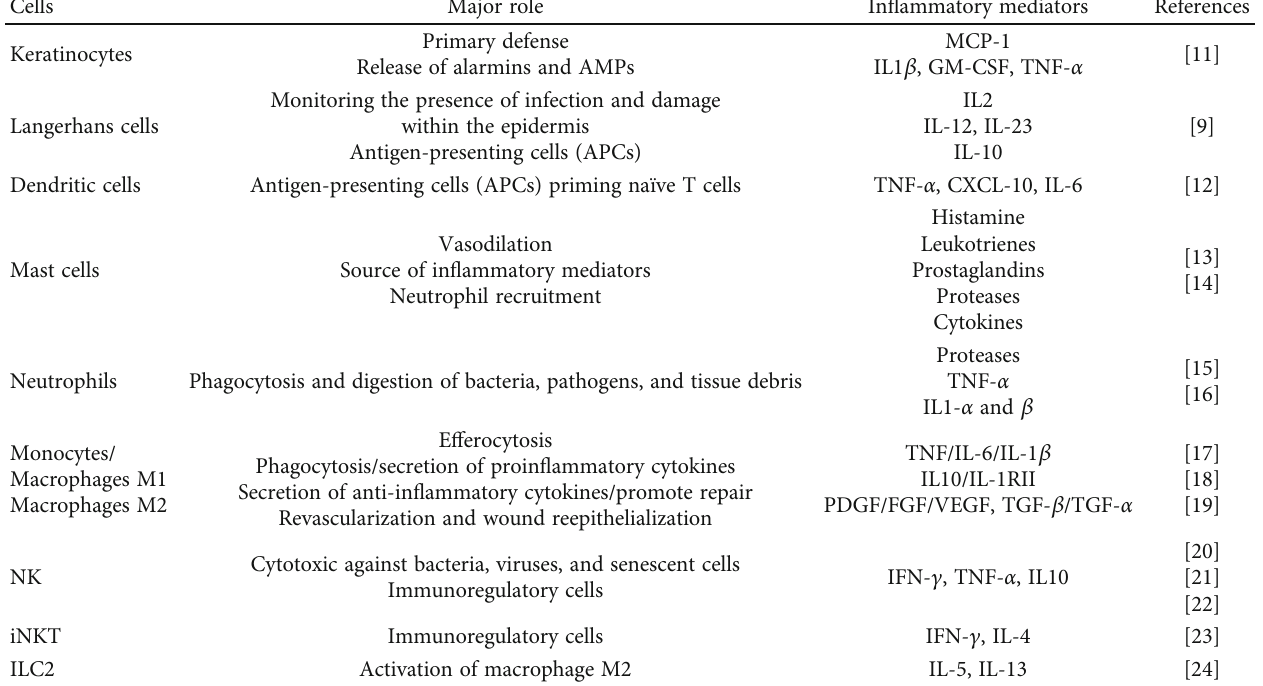
Table 1: Major roles of resident or recruited innate immune cells in the in fl ammatory phase.